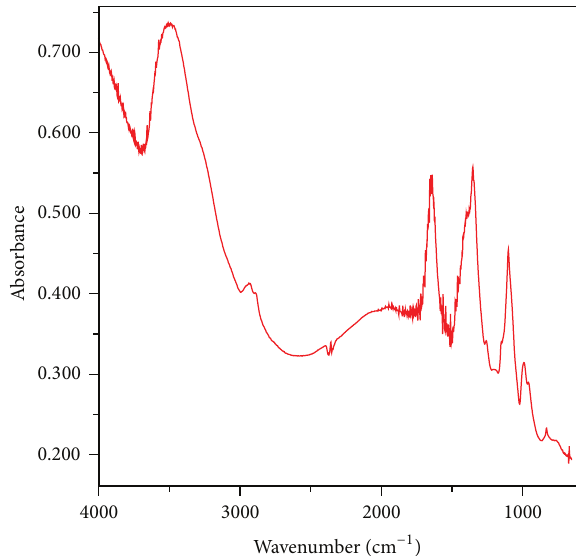
O anode acting as 2 5